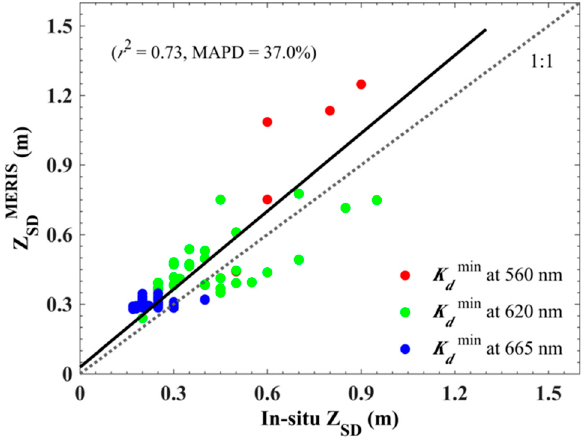
Figure 10. Comparison between in-situ and MERIS-derived Z SD , where the color denotes the wavelength of minimum K d . wavelength of minimum K d